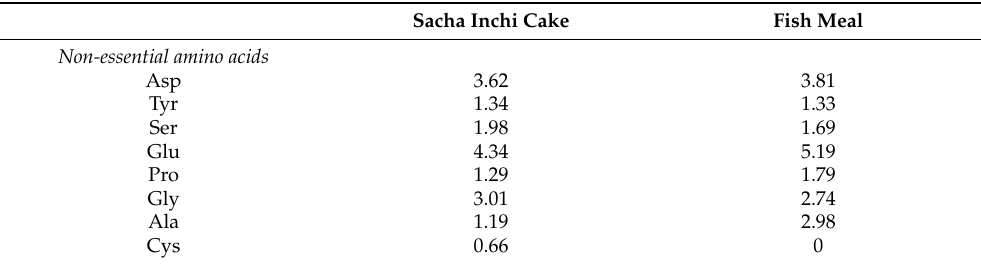
Table 1. Amino acid composition (g % 100 g dry matter) of sacha inchi cake compared to fish meal as